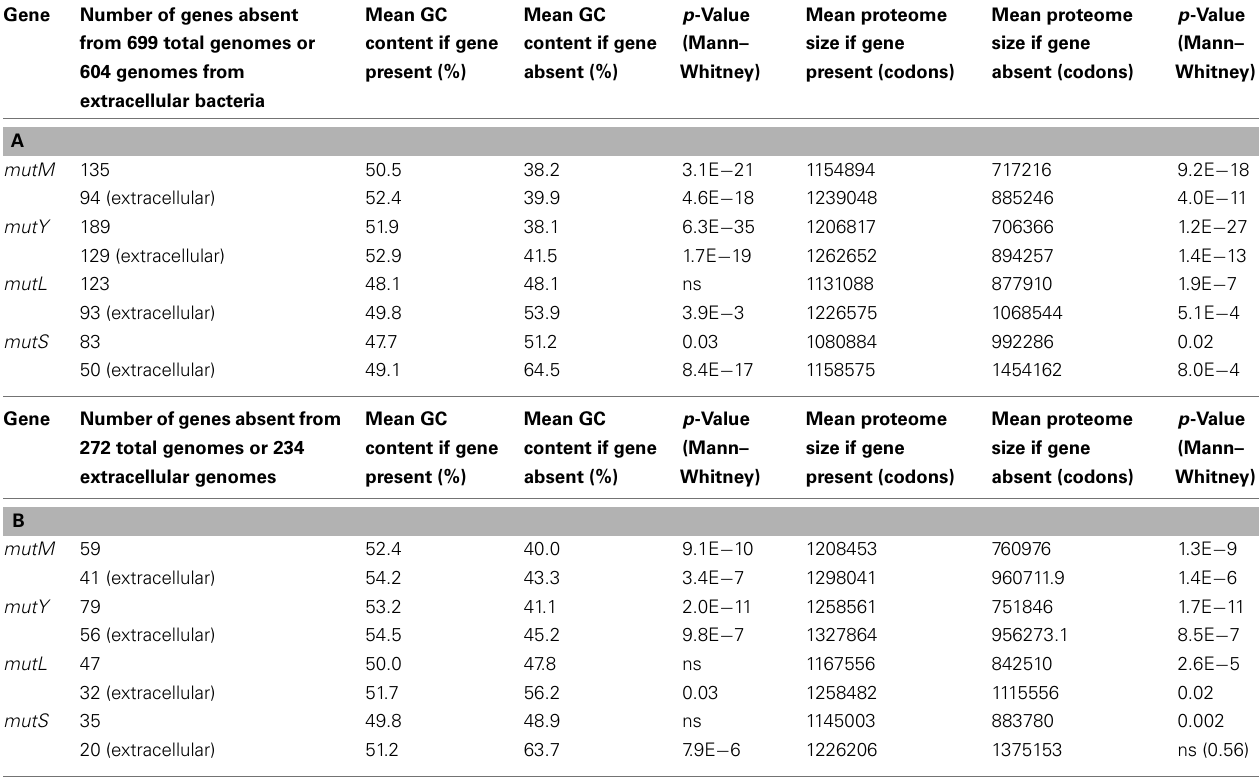
Table 1 | Mean GC contents and proteome sizes of bacterial genomes that possess or lack the DNA repair genes mutM , mutY , mutL , and